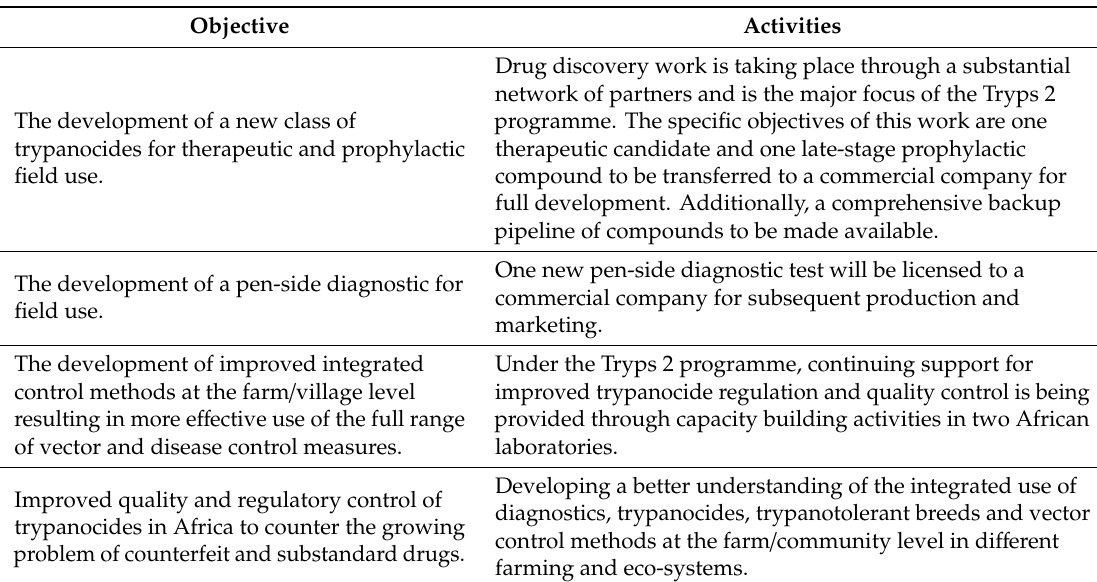
Table 3. GALVmed’s programme objectives for Animal African